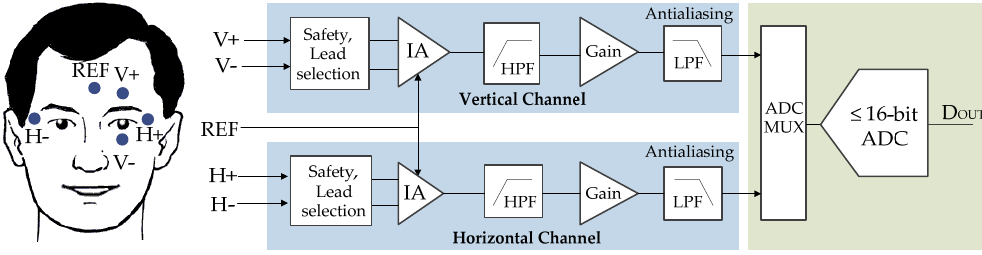
Figure 2. Typical EOG signal chain based on low ‐ resolution analog ‐ to ‐ digital converters (ADCs).